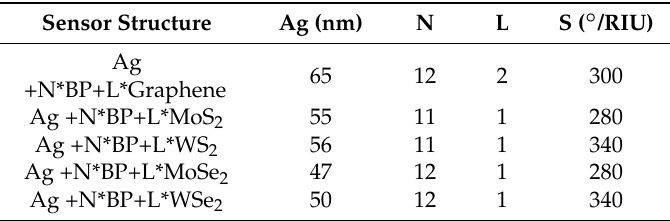
Table 3. Genetic optimization.